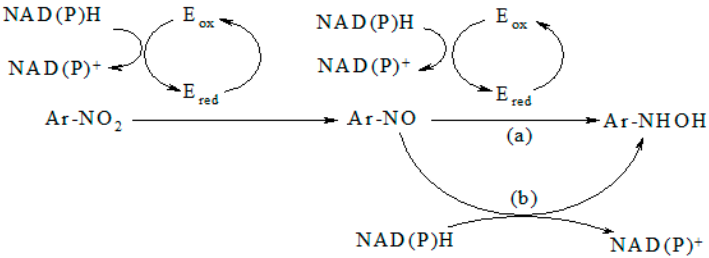
Scheme 1. Pathways of enzymatic (a) and nonenzymatic (b) formation of Ar-NHOH from Ar-NO.